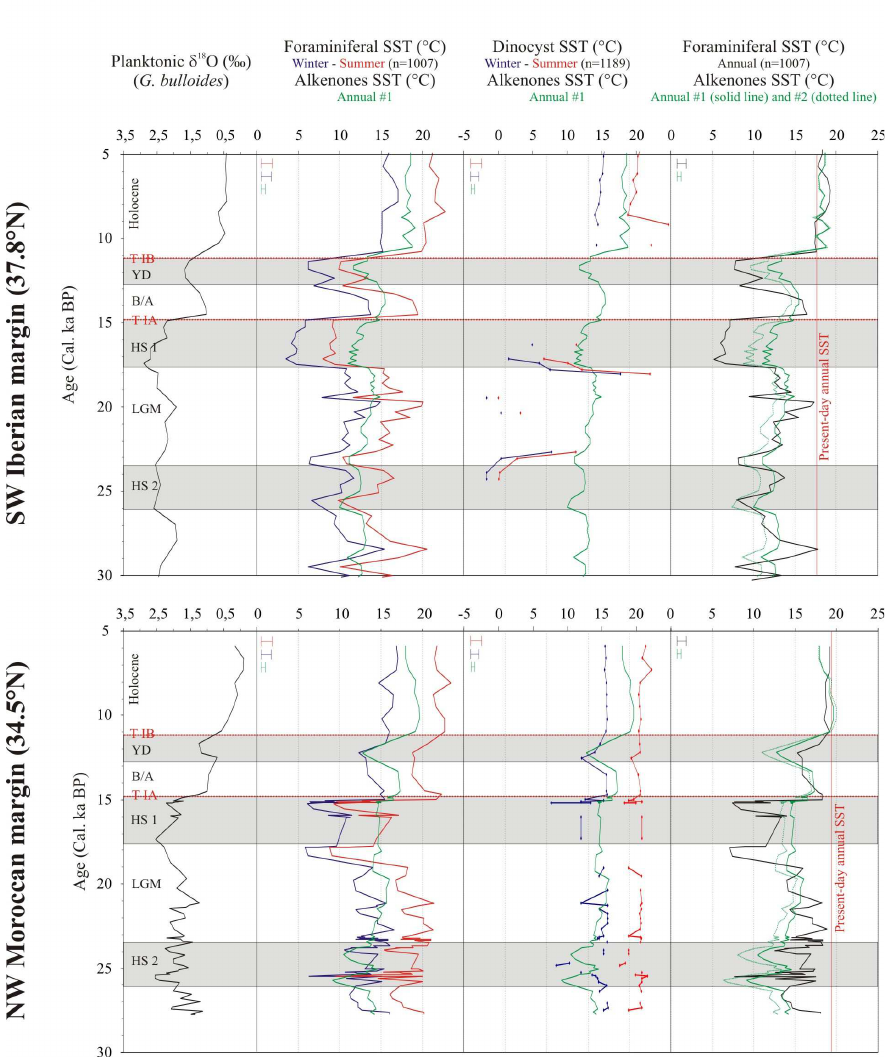
Fig. 6. SW Iberian margin (MD95-2042) and NW Moroccan margin (MD04-2805 CQ). Dinocyst SST reconstructions (February and August, 3PBase-940) and foraminiferal SST reconstructions (winter, summer and annual, R-1007) are compared with SST provided by alkenones 0 (U k – SST). Two different calibrations have been used to convert the C 37 alkenone unsaturation data in terms of SST: #1 corresponds to 37 Prahl et al. (1988) and #2 corresponds to Weaver et al. (1999). Error bars are shown for the different reconstructions. YD: Younger Dryas; B/A: B¨olling-Allerød; HS: Heinrich Stadial; LGM: Last Glacial Maximum; TI: Termination